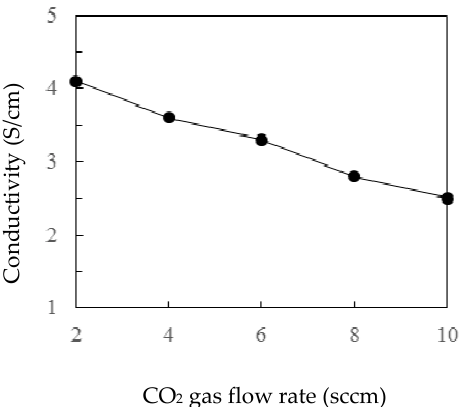
Figure 3. Conductivity of a-SiO x films as a function of CO 2 flow